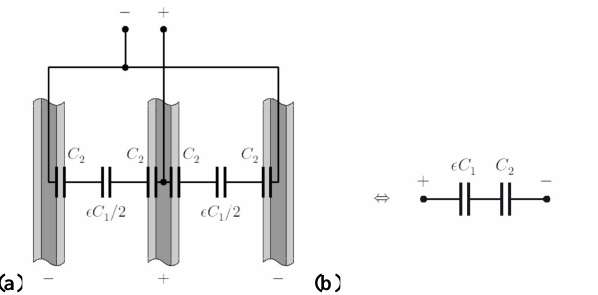
Fig. 2 : Total capacitance C of a 3-rod-probe as a function of the soil’s dielectric permittivity e . (A) segment of three parallel rods encompassed by soil; light grey: PVC coating; dark gray: metallic core; (B) equivalent circuit. C 1 , C 2 : constant capacitance parameters determined by the probe’s geometry (Becker, 2004).